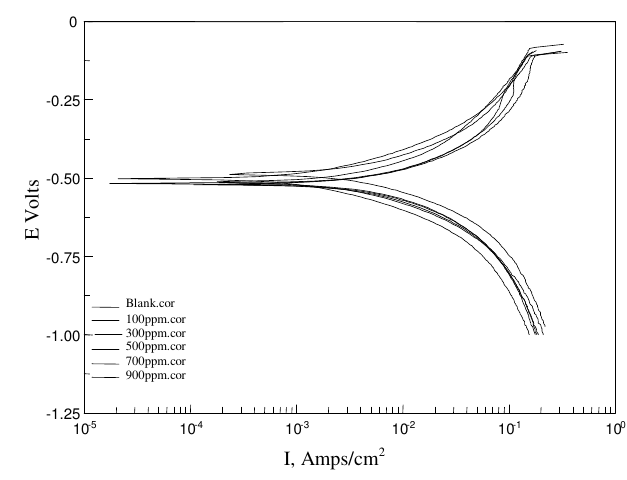
Figure 2. Polarization curve of MS in presence of PGA in 0.1 M HCl Table 4. Electrochemical and corrosion parameters for MS in the presence of PGA in 1 M HCl